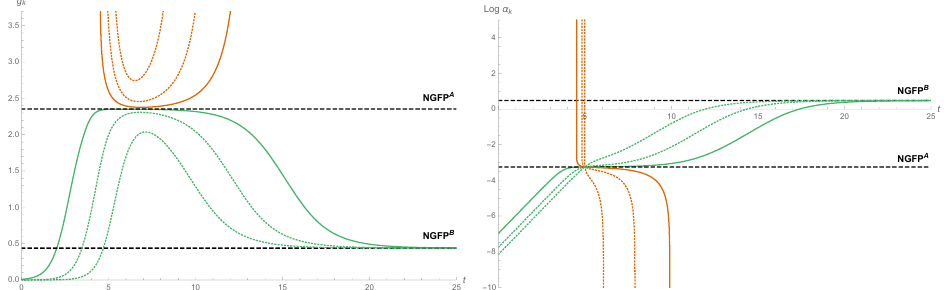
Figure 15. Illustration of the interplay between the three fixed points (56)–(58) for N f = 3 and β = − 1/4. The left and right panel show g k and (the logarithm of) α k -component obtained from solving the full system of beta functions numerically as a function of t ≡ log k . The green lines correspond to the UV-safe trajectories emanating from NGFP B . The thick green line marks the crossover from NGFP B to NGFP A and constitutes the barrier between the safe and unsafe trajectories depicted in orange. For small values t , the flow undergoes a second cross-over from NGFP A to the GFP. The linear decrease of log α k in this regime is characteristic for the dimensionful coupling obtaining a constant ( k -independent)